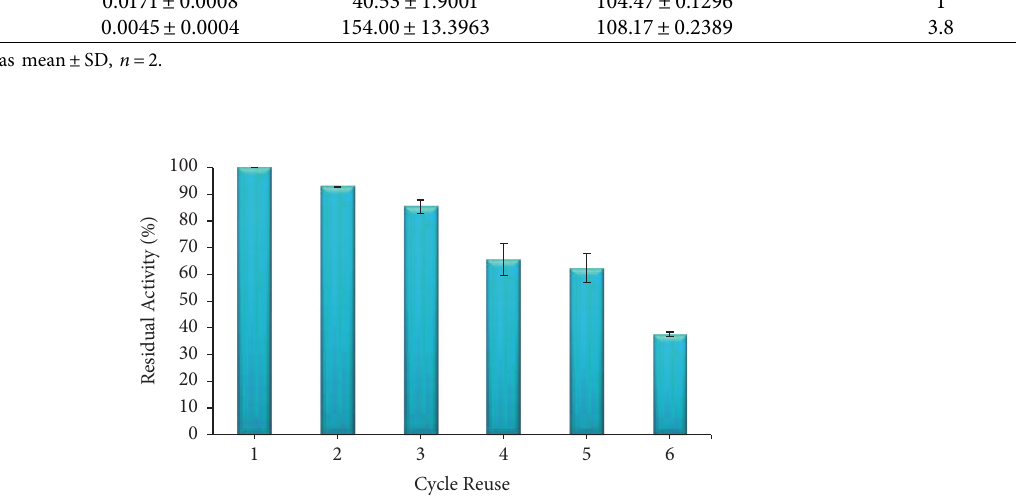
Figure 8: Reuse cycle of the immobilized enzyme. The data are presented as mean ± SD; n � 2; p ≤ 0 . 05. The error bars represent standard deviations from two replicates measurements.